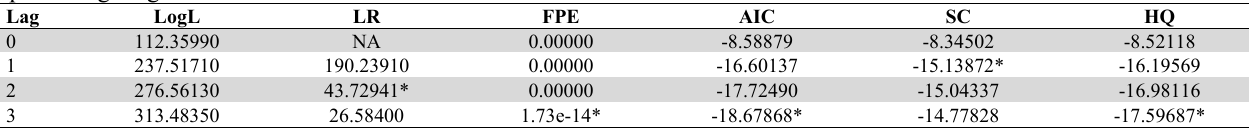
Optimal lag length results